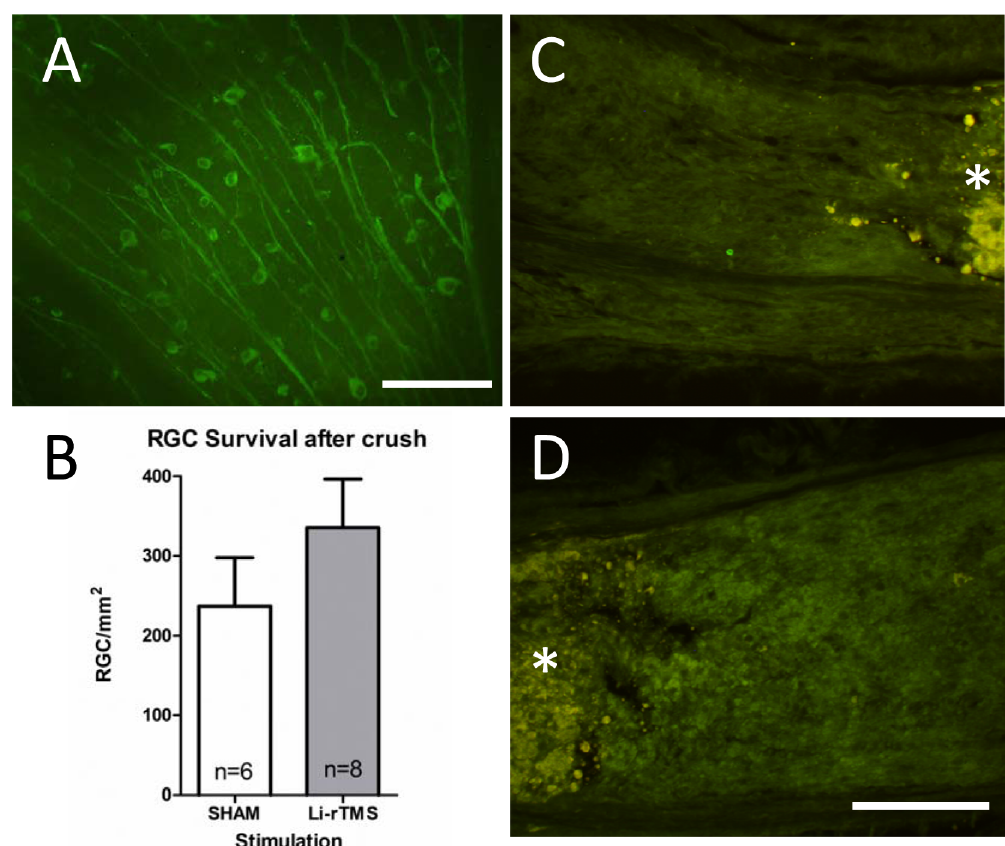
Fig 2. LI-rTMS does not affect RGC survival or axonal regeneration following optic nerve crush. A: photomicrograph showing RGCs immunolabelled with β 3 tubulin following an optic nerve crush and 2 weeks of daily LI-rTMS. Scale bar is 100 μ m. B: Histogram showing counts of surviving RGCs in LI-rTMS and sham stimulated retinas 2 weeks following an optic nerve crush. There was no significant difference between the stimulation groups (p = 0.256). Error bars are standard error of the mean. C, D: GAP-43 immunohistochemistry in the proximal (C) and distal (D) optic nerve did not result in labelling of any axons. The crush site is indicated by * . Scale bar 100 μ